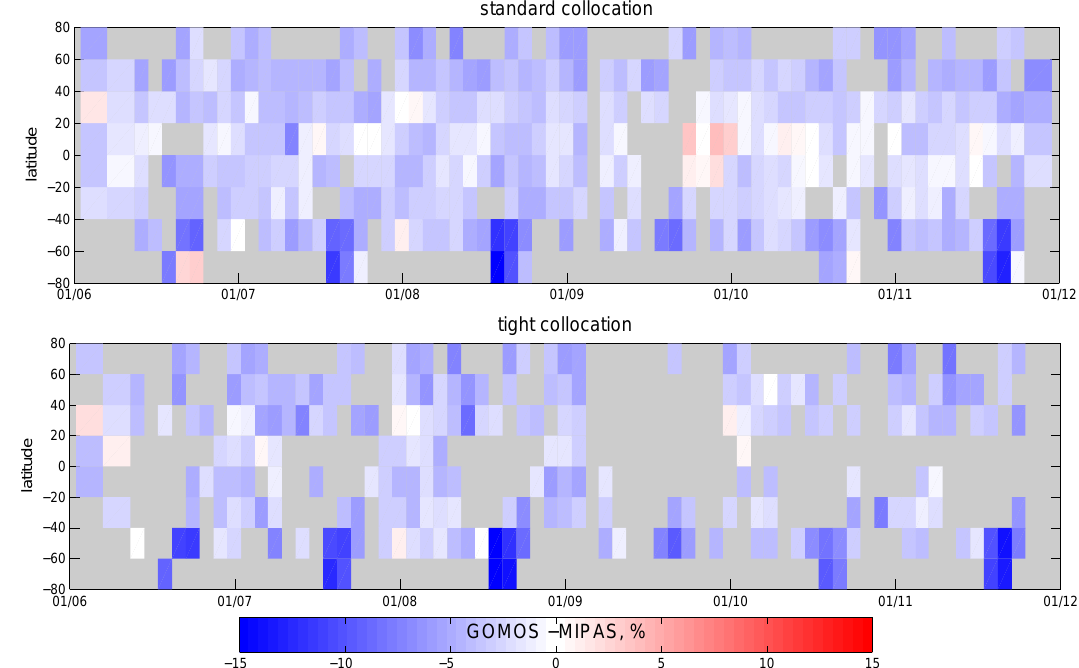
Figure 5. GOMOS minus MIPAS (in % indicated by color scale) at 30km, as a function of latitude and time, for standard (top) and tight (bottom) collocation